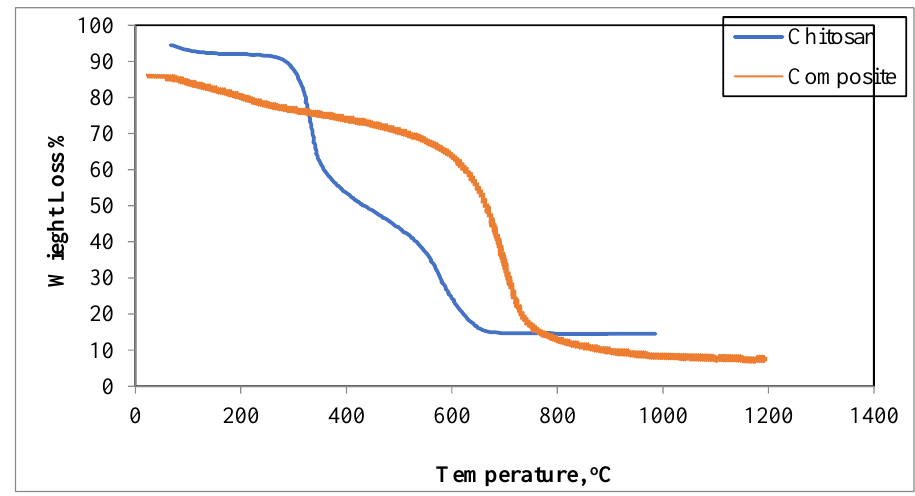
8 of 20 Figure 5. X-ray diffractions (XRD) for chitosan, halloysite, Zn@Fe 3 O 4 , and composite. 3.1.4. Thermal Analysis The thermal decomposition of chitosan (TGA curve) is shown in Figure 6. In this curve, there are two decomposition stages. The first one begins at 60 °C, with a 6% weight loss due to the water loss. The second one nearly starts at 150 °C with a weight loss of about 47%. It stabilizes at 350 °C, and eventually reaches a total weight loss of 59% at